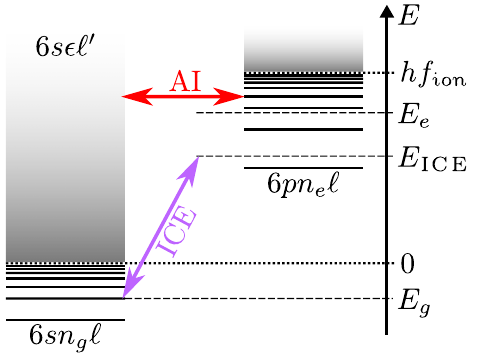
FIG. 1. The energy-level diagram (not to scale) for the MQDT treatment of ICE with two channels. The purple arrow represents an ICE photon connecting the initial state in the 6 sn g (cid:2) Rydberg series with a ground-state core to a Rydberg series 6 pn e (cid:2) with an excited core. The red horizontal arrow shows AI as a coupling between this doubly excited series and the continuum state 6 s (cid:3)(cid:2) (cid:2) , where (cid:3) is the kinetic energy of the ejected electron. The energy scale on the right introduces the energy levels (dashed, horizontal lines) used in the MQDT treatment. The two Rydberg-series ion- ization limits are represented using horizontal dotted lines. With the first taken as energy reference, the second has an energy hf ion